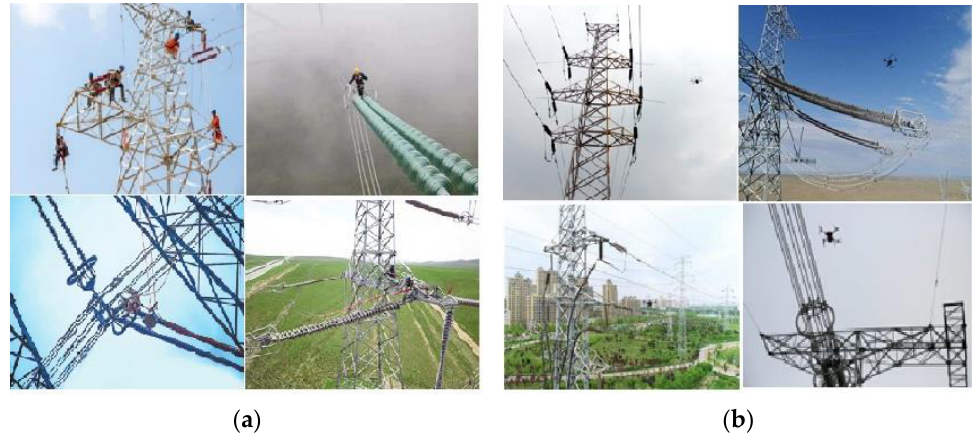
Figure 1. Insulator inspection. ( a ) Manual inspection. ( b ) UAV inspection.